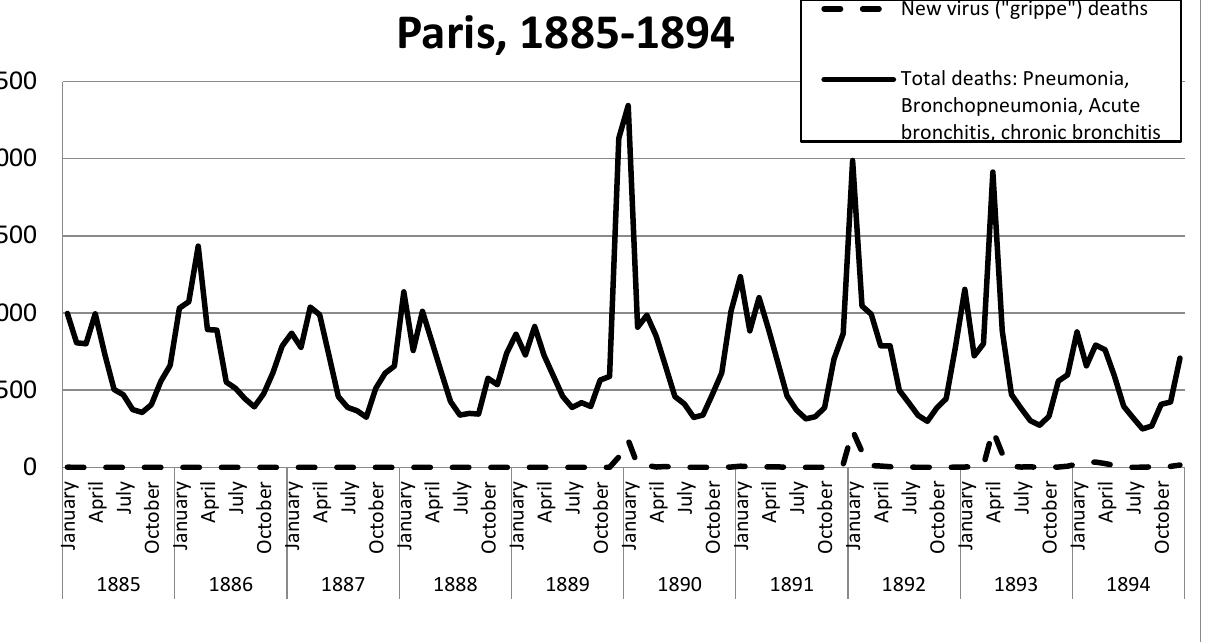
Figure 2. The continuous line shows the deaths from pneumonia, bronchopneumonia, acute bronchitis and chronic bronchitis from 1885 to 1894. The dotted line below shows deaths from the new virus called ‘grippe’. Source: “Annuaire statistique de la ville de Paris” [15].